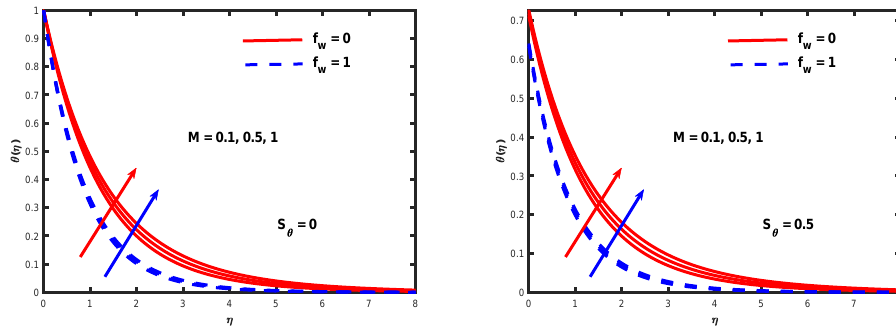
Figure 9. Influence of material and suction/injection parameter on θ